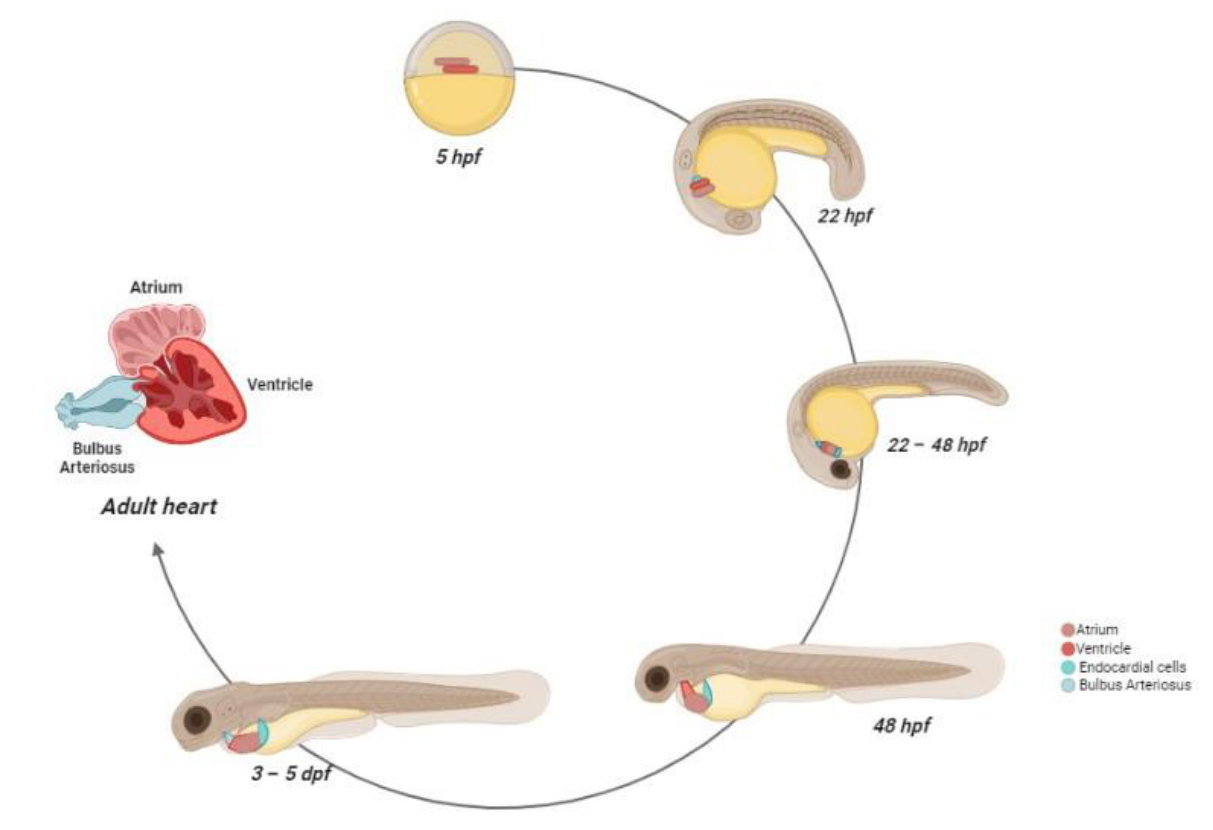
Figure 2. Zebrafish heart development. At 5 hpf, the cardiac progenitors are positioned in the lateral marginal zone. The atrial progenitor cells are located more ventrally than the ventricle progenitors, positioned at the margin site. At 22 hpf, the progenitors express chamber-specific genes, inducing cell structure differentiation. After this process, the cells reach the midline and, after the fusion with the developing endocardial cells, form the cardiac disc, where atrial cardiomyocytes surround the ventricle cells. Between 22–24 hpf, the heart starts beating. At 28 hpf, the cardiac disc elongates, forming a linear heart tube, which, in turn, begins before the leftward migration and then the looping. At 48 hpf, the heart chambers are now formed and easily distinguishable, and the bulbus arteriosus and the sinus venosus are matured as blood outflow and inflow tracts, respectively. At 72 hpf, the trabeculae formations start and rapidly expand in the developing heart. The pacemaker cells are localized in the inner curvature of the atrium. Between the larval and juvenile stage, the atrium and ventricle rotate, so that the ventricle is positioned ventrally to the atrium. At the adulthood stage, the coronary arteries feed the ventricle and a compact myocardium is formed.